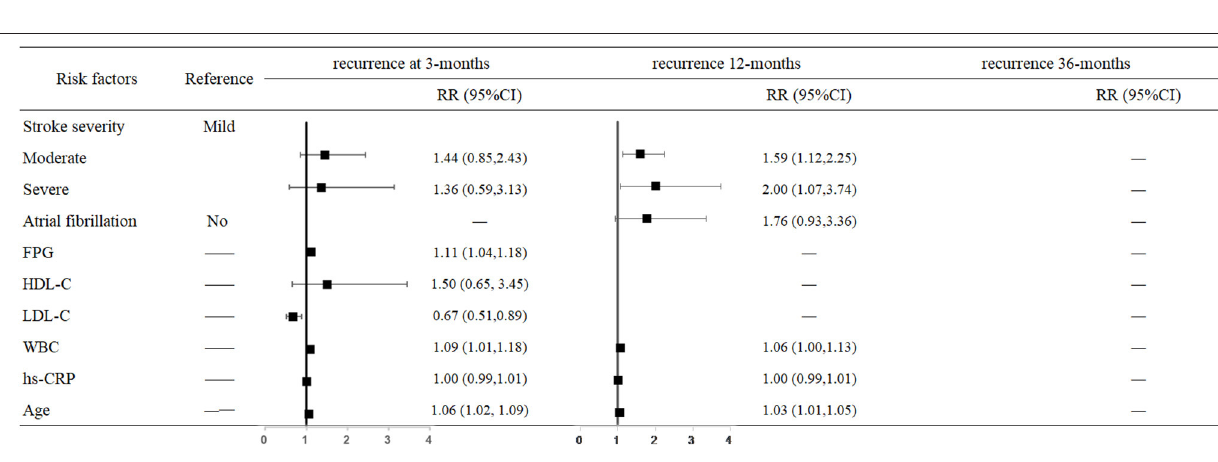
at both 3 months (RR = 1.06, 95% CI: 1.03–1.10, P < 0.001) and 12 months (RR = 1.04, 95% CI: 1.01–1.06, P = 0.002) after